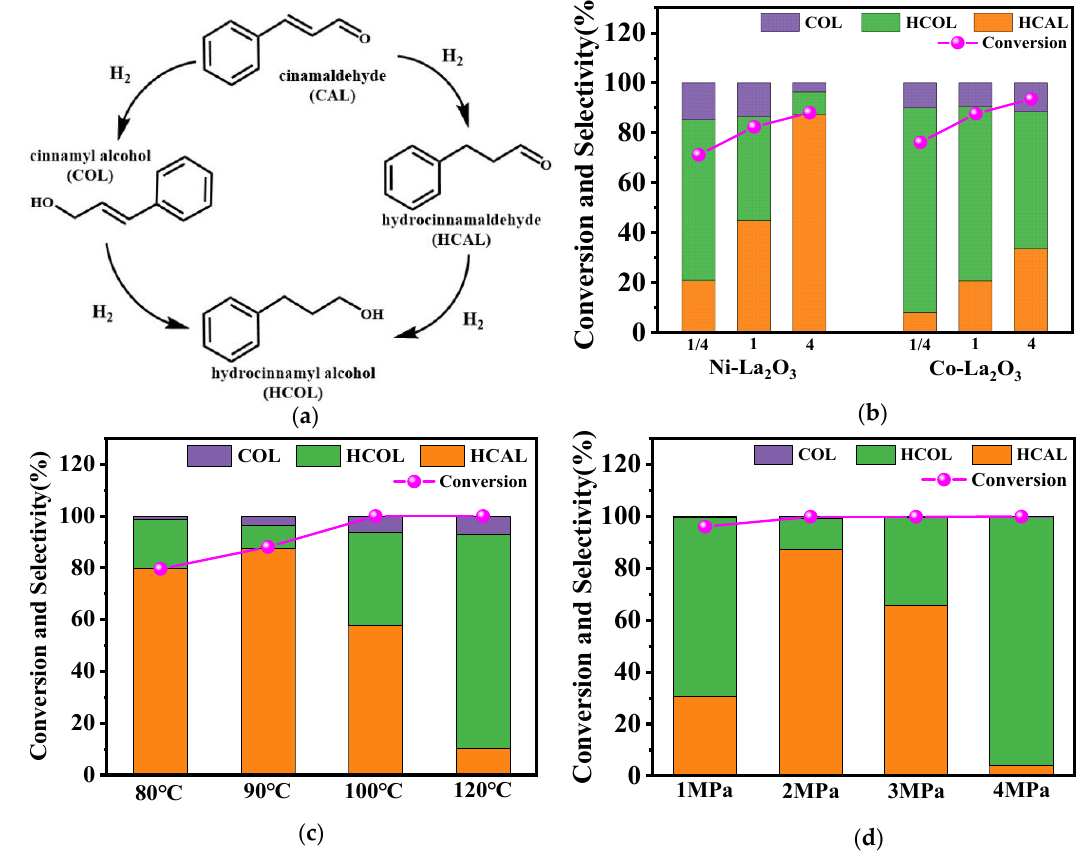
Figure 4. The process for selective hydrogenation of CAL ( a ), catalytic performance over various Ni x -La 2 O 3 and Co x -La 2 O 3 catalysts ( b ), reaction conditions: 0.55 mmol CAL, 50 mg catalyst, 6 mL absolute ethanol as solvent, 2 MPa H 2 , reaction temperature 90 ◦ C, reaction time 2 h. Influence of reaction temperature ( c ) and hydrogenation pressure ( d ) on the selective hydrogenation of CAL over Ni 4 -La 2 O 3 .